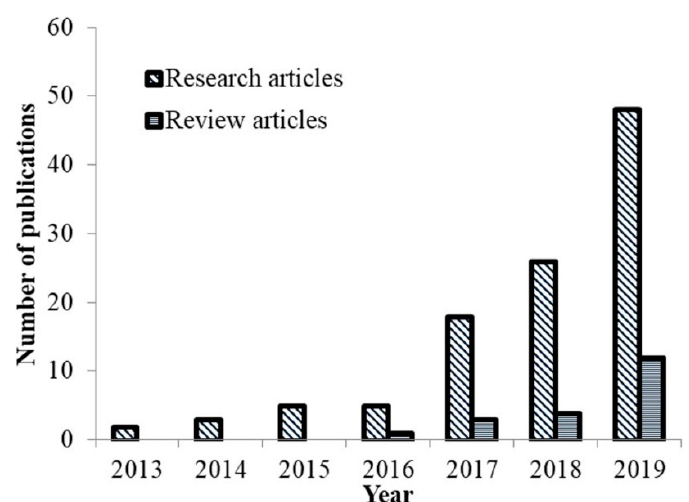
Figure 2. Published works related to the deep eutectic solvents / natural deep eutectic solvents (DES / NADES) in the extraction of bioactive compounds. Web of Science (WoS) search results, all of which contained the words “deep eutectic solvents” and “bioactive compounds” or “extraction” either in the title or in the abstract or in the keywords ( search data : 18.08.2020.).